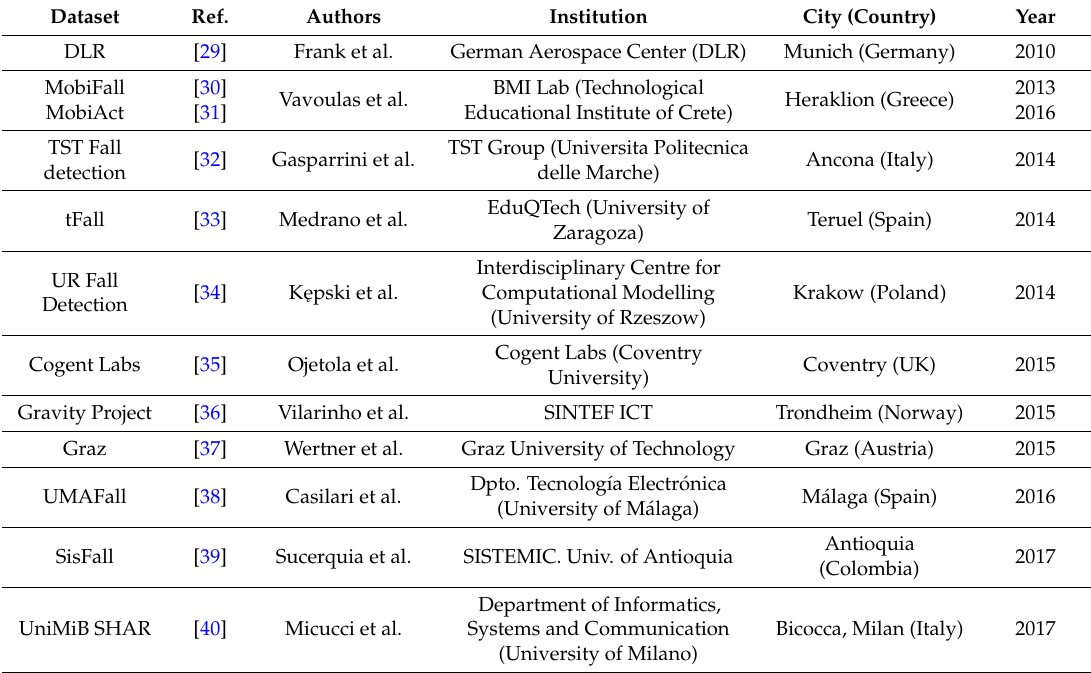
Table 1. Basic characteristics of public datasets of falls and Activities of Daily Living